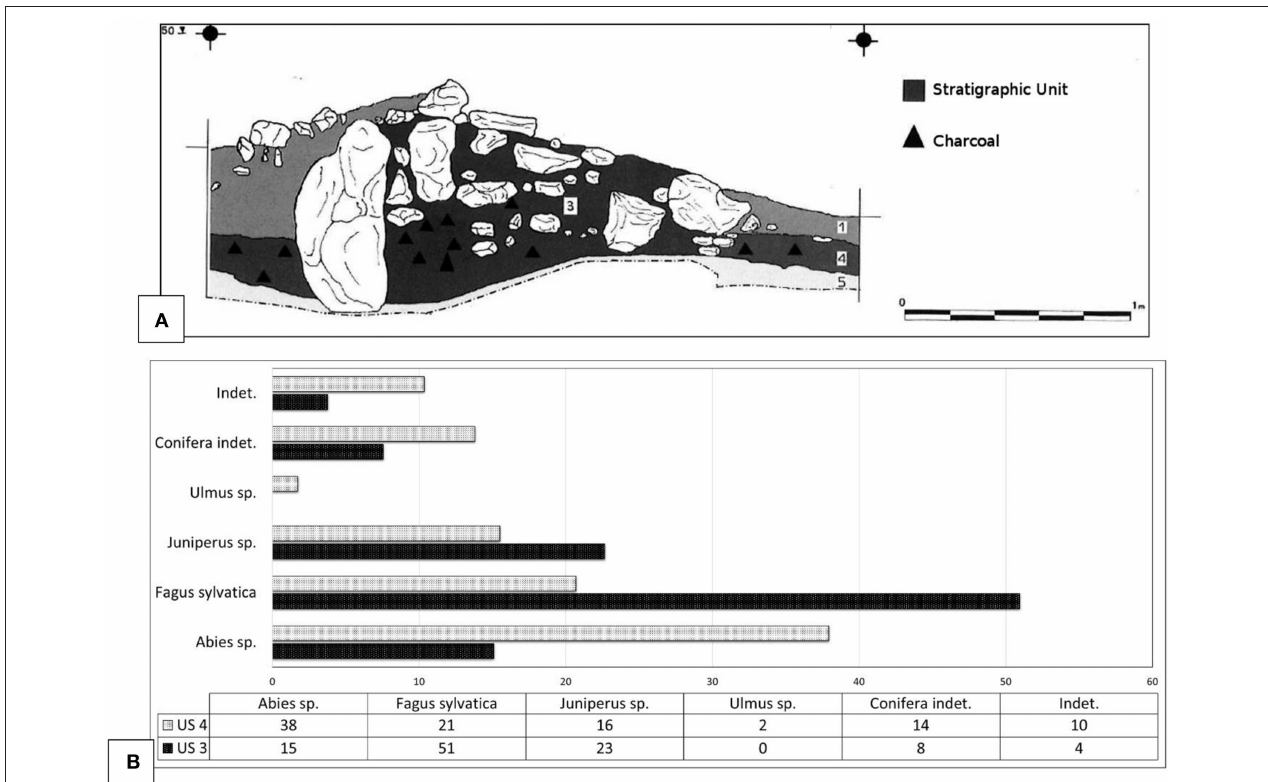
FIGURE 6 | (A) T1 soil profile in Paltineri (2002) with relative stratigraphic units and presence of buried charcoals representation of charcoal fragments presence; (B) Results of anthracological analysis of US 3 and US 4 (percentages).